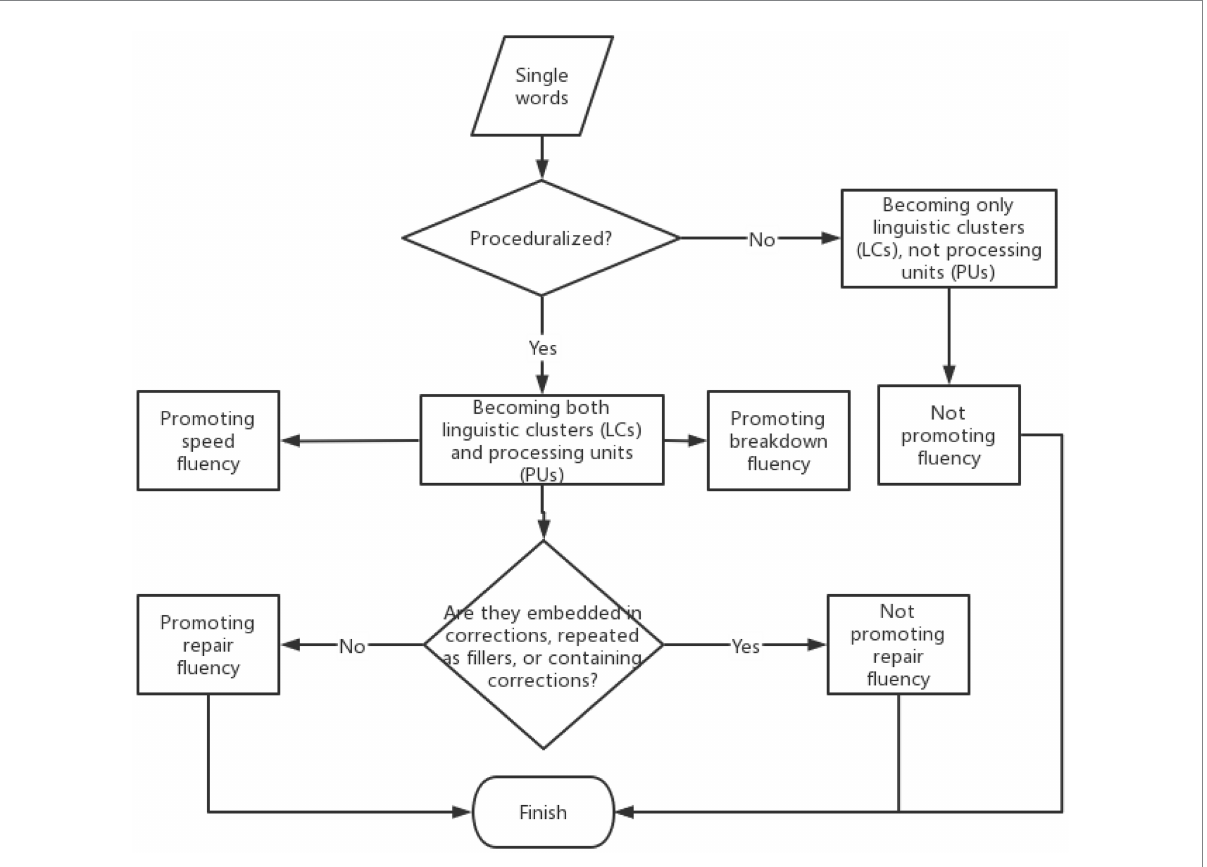
FIGURE 4 A new framework of proceduralization of formulaic sequence